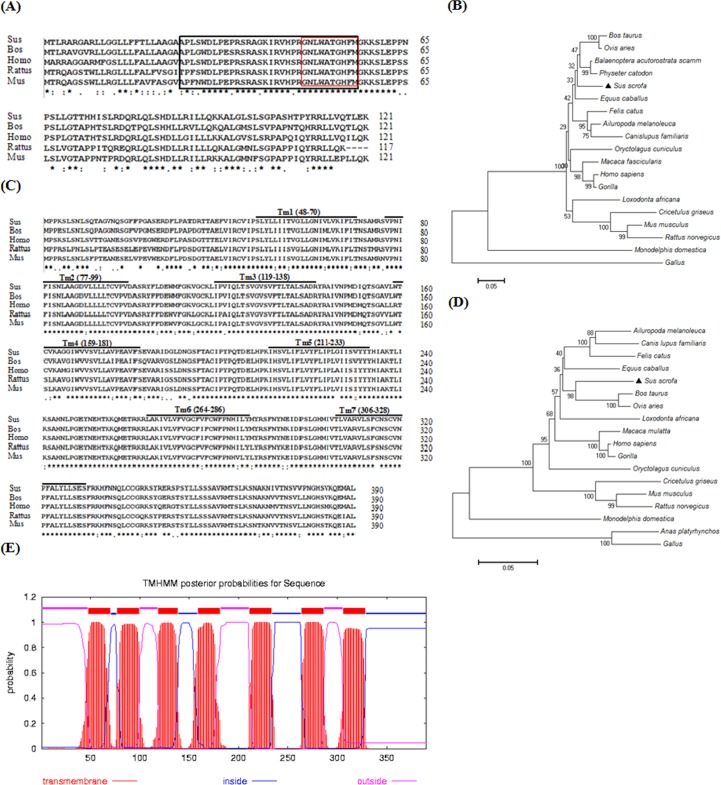
Sequence analysis of the pig NMB precursor and NMBR.Panel (A): multiple alignment of deduced aa sequences of the pig NMB precursor in several mammals. The conserved sequence of NMB-32 and NMB-10 is shown in the box. GenBank ID: Bos taurus NP_001068738.1, Homo sapiens AAH08603.1, Rattus norvegicus NP_001102619.1, and Mus musculus NP_080799.1. Identifiers: “*” identical, “.” and “:” conservative replacements, “” mismatches. Panel (B): phylogenetic tree analysis of NMB aa sequences. Panel (C): multiple alignment of the deduced aa sequences of the pig NMBR in several mammals. The putative transmembrane regions are indicated by horizontal bars. GenBank ID: Bos taurus NP_001192639.1, Homo sapiens AAA59939.1, Rattus norvegicus NP_036931.1, and Mus musculus NP_032729.1. Panel (D): phylogenetic tree analysis of NMBR aa sequences. Panel (E): transmembrane region of the pig NMBR aa sequence fragment. 1–47 aa, 100–118 aa, 182–210 and 287–305 aa, outside sequence; 48–70 aa, 77–99 aa, 119–138 aa, 159–181 aa, 211–233 aa, 264–286 aa and 306–328 aa, TMhelix sequence; 71–76 aa, 139–158 aa, 234–263 aa and 329–390 aa, inside sequence.